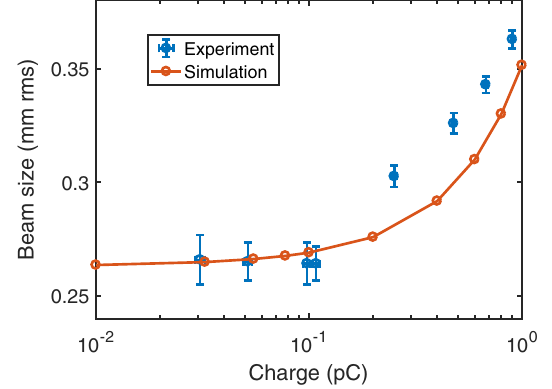
FIG. 11. The measured transverse momentum distribution and different emission models in ASTRA code, which are FD300, isotropic and Gaussian,